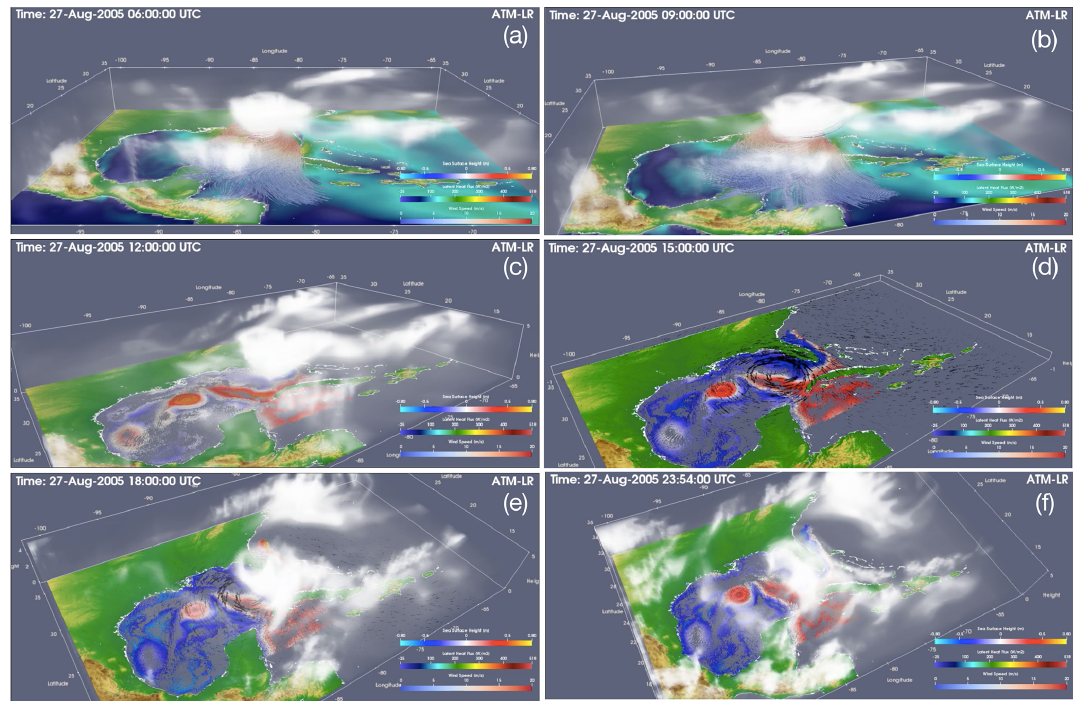
Figure 12. Rendering of the multicomponent (ATM-OCN-COP) fully coupled simulation using ParaView. The temporal interval for the processed data is defined as